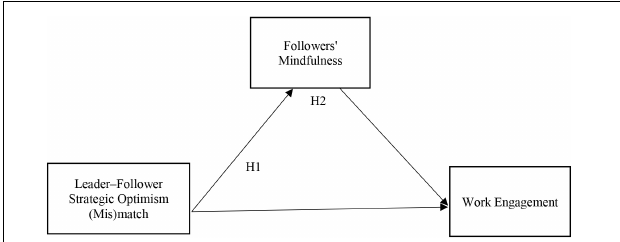
FIGURE 2 | Research model with hypotheses.